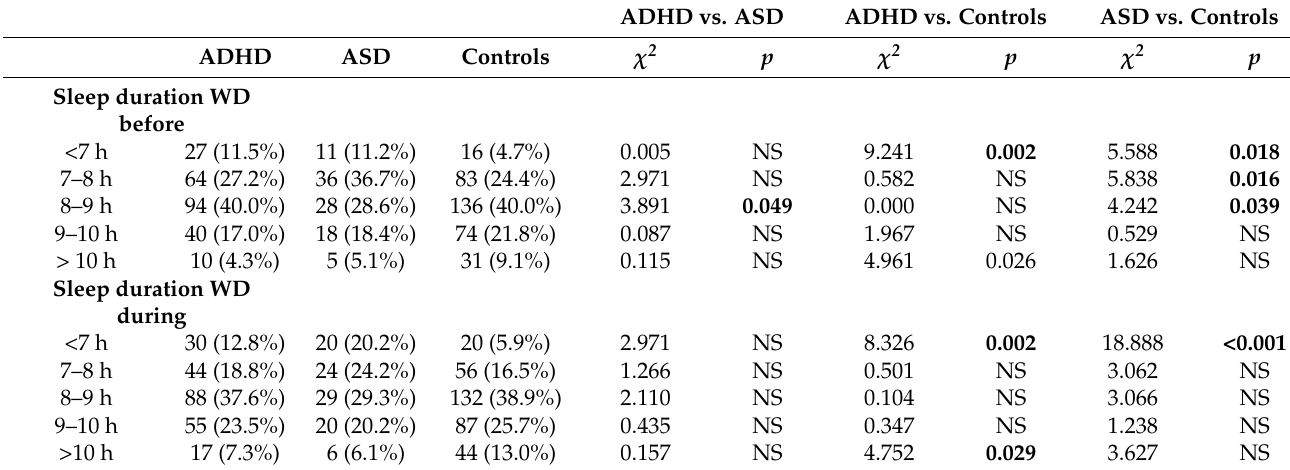
WD = weekday. Significant differences at p < 0.05 are in bold.